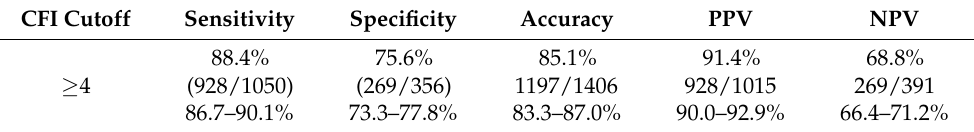
Table 2. Statistical results using Comprehensive Facial Injury (CFI) score ≥ 4 as lower